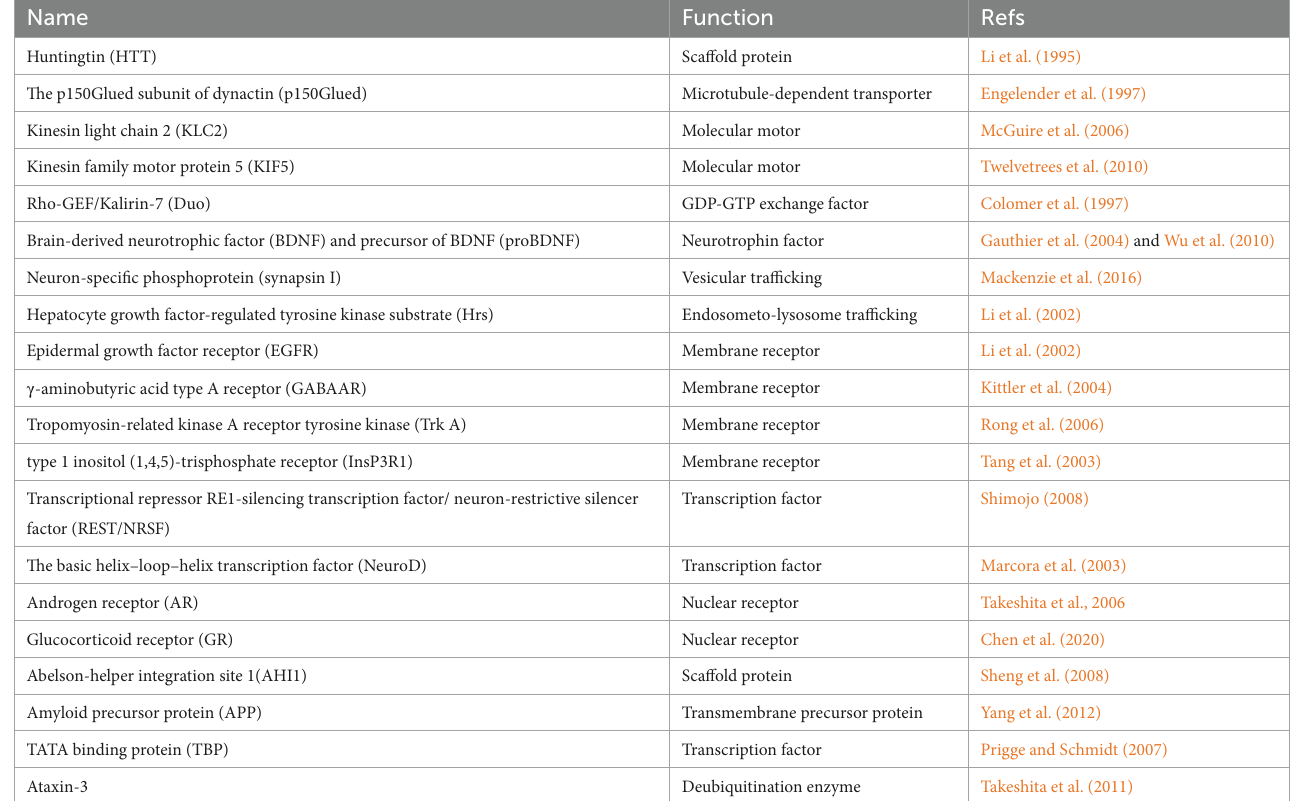
TABLE 1 HAP1-interacting